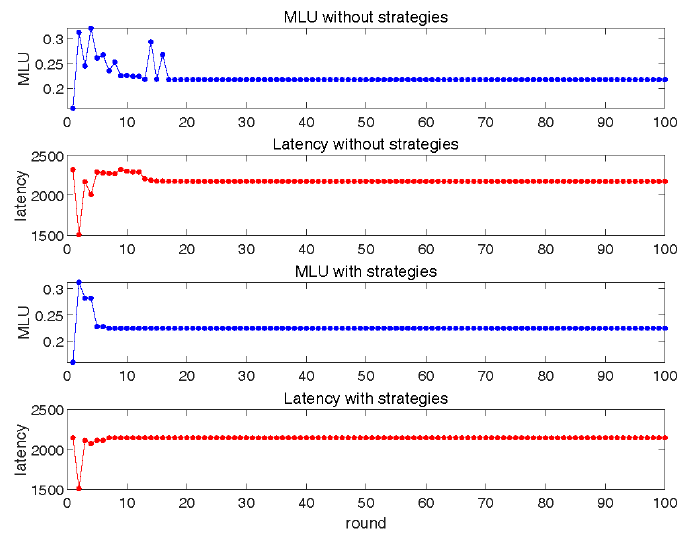
Figure 10. Interaction between SRC with control plane fault correction and LLS.